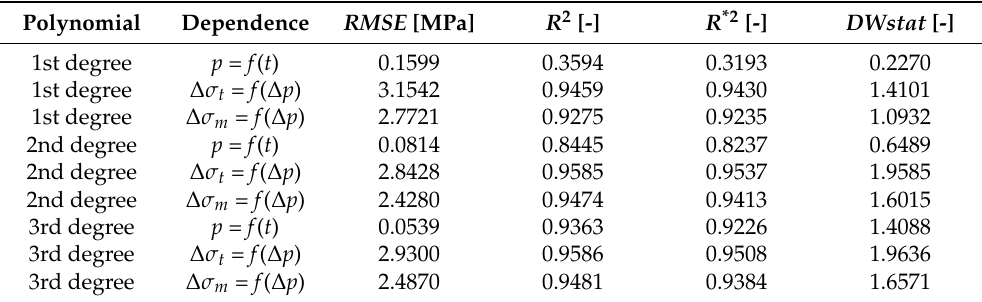
Table 4. Parameters of correlation analyses of proposed polynomial models of individual